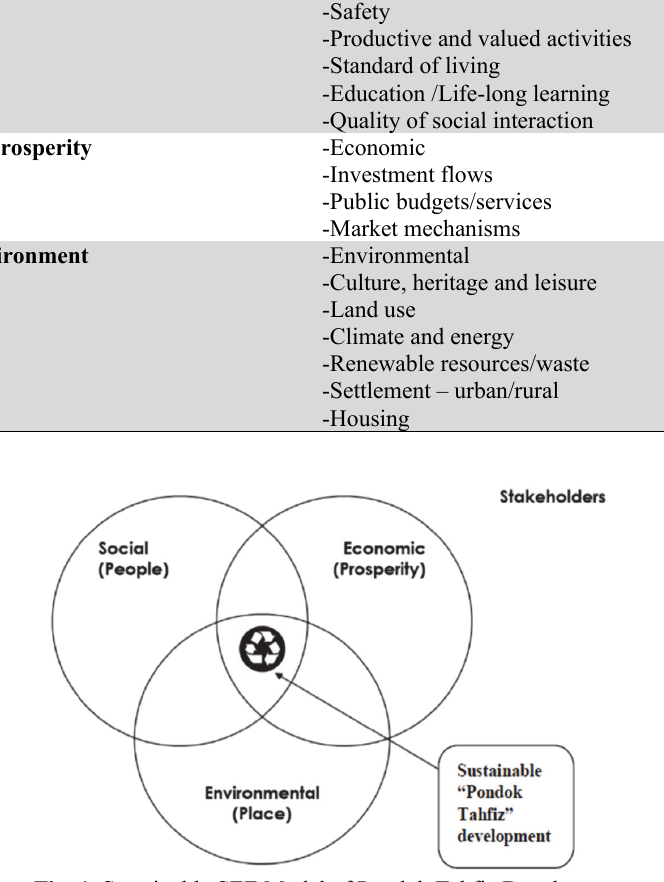
Fig. 1. Sustainable SEE Model of Pondok Tahfiz